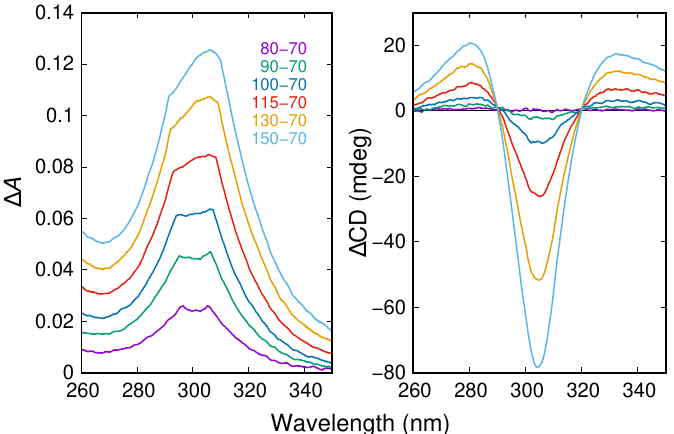
Figure 6. The difference absorption ( left ) and CD ( right ) spectra 80–150 min from the start of the reaction from the experiment in Figure 5. The spectrum at 70 min was taken as a reference. Time labels in minutes apply for both